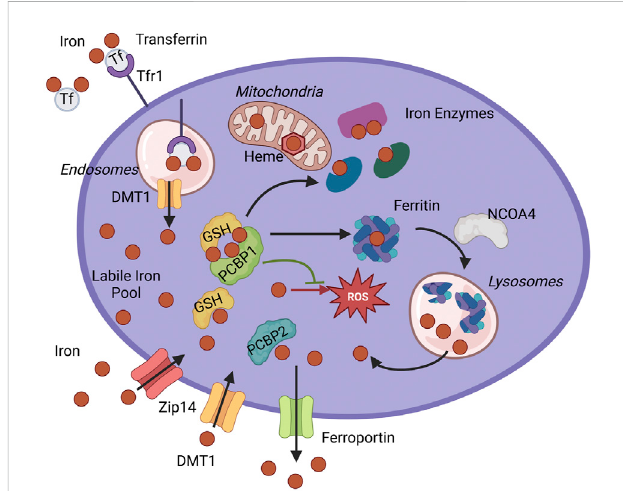
FIGURE 1 Iron chaperone management of intracellular iron. PCBP1 and PCBP2 ensure the safe distribution of iron into three main pools of cytosolic iron: storage, use in iron enzymes, and labile iron pool (LIP). Iron enters cytosol as non-transferrin-bound iron through Divalent metal transporter 1 (DMT1) or Zip14 and as transferrin-bound iron through Transferrin receptor 1 (Tfr1). The iron-transferrin complex dissociates in the acidic lumen of the endocytic compartment, and iron is transported into the cytosol by DMT1. Iron enters the cytosolic labile iron pool (LIP) as Fe(II) and is primarily coordinated by reduced GSH and iron chaperones, PCBPs. PCBP1 and possibly PCBP2 deliver iron for storage in ferritin. Sequestered iron is freed after targeting ferritin